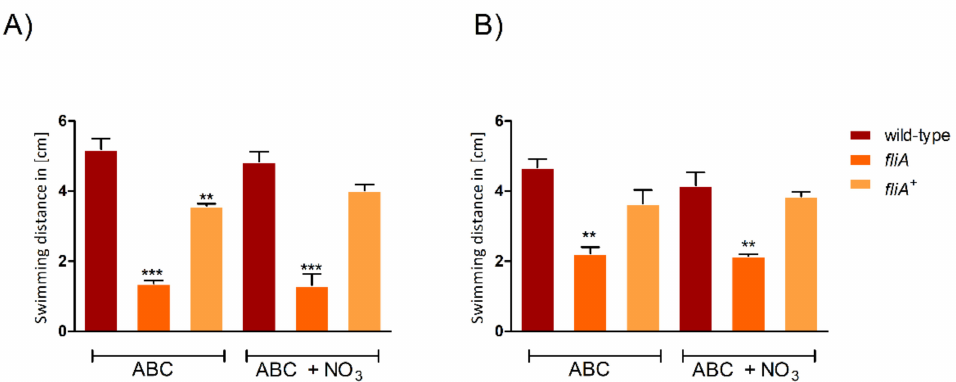
Figure 7. Swimming in aerobic ( A ) and micro-oxic ( B ) conditions of B. cenocepacia wild-type, a fliA mutant and the complemented strain ( fliA + ) in ABC or in ABC with 10 mM NaNO 3 after 24 h. Y-axis = swimming distance in cm. Three biological replicates were performed. Error bars = SD, p -value ** < 0.01, *** < 0.001).